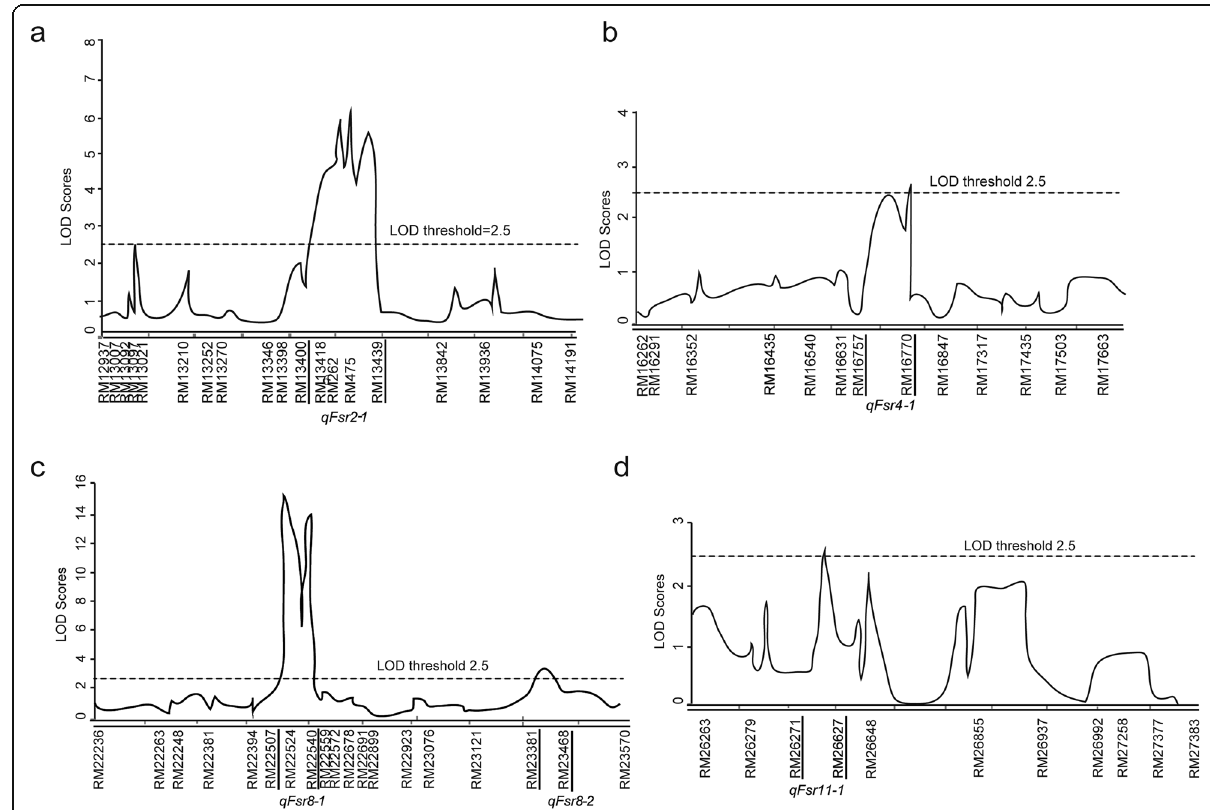
Fig. 4 Five QTLs were identified on chromosomes 2 ( a ), 4 ( b ), 8 ( c ) and 11 ( d ) using the F 7 population derived from a hybrid of MR183 – 2 and 08R2392. The dotted lines showed a threshold value of LOD (LOD > 2.5)